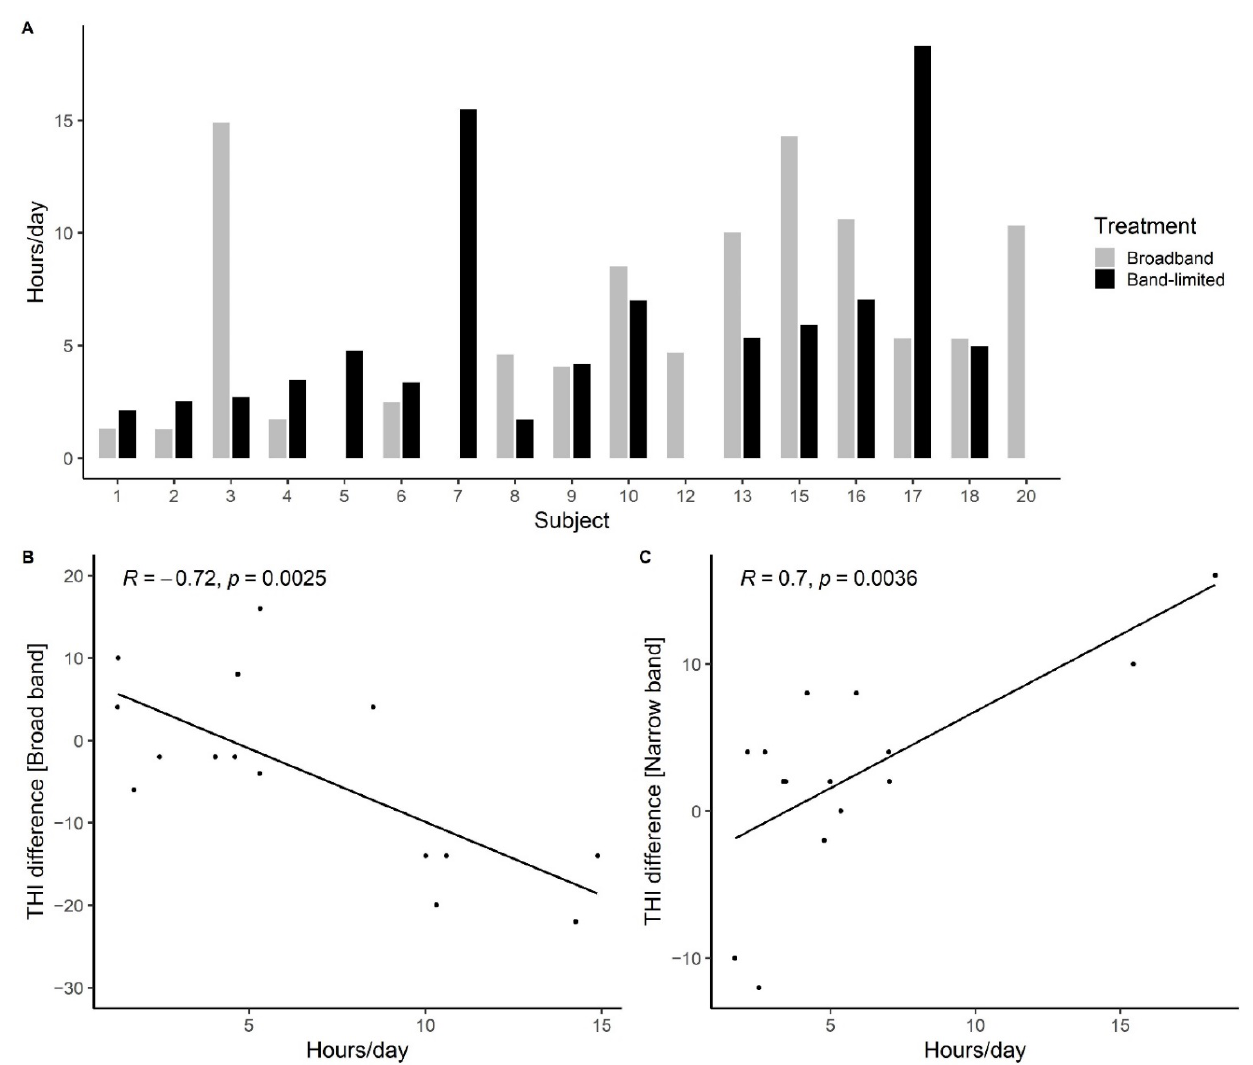
Figure 9. ( A ) Overview of the number of hours/day the hearing aids have been switched on. ( B ) Pearson’s correlation between the THI difference before/after the use of broadband amplification and the amount of hours/day the HAs were active. ( C ) Correlation between the THI difference before/after the use of band-limited amplification and the amount of hours/day the HAs were active.